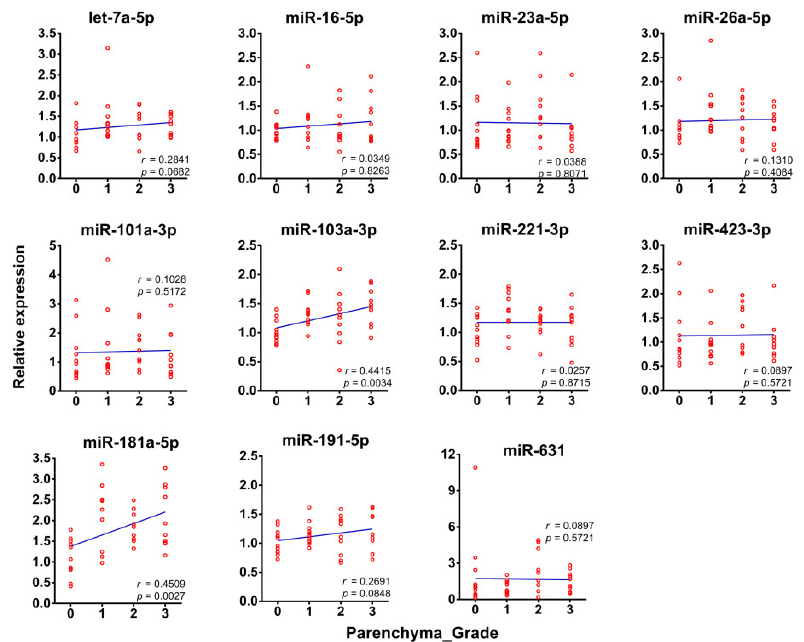
Figure 5. Correlations of the levels of the eleven exomiRs in serum (using the most stable exomiR miR-425 as reference) with hepatic fibrosis grades in the cohort subset employed for endogenous RGs identification (Spearman’s correlation coefficient).